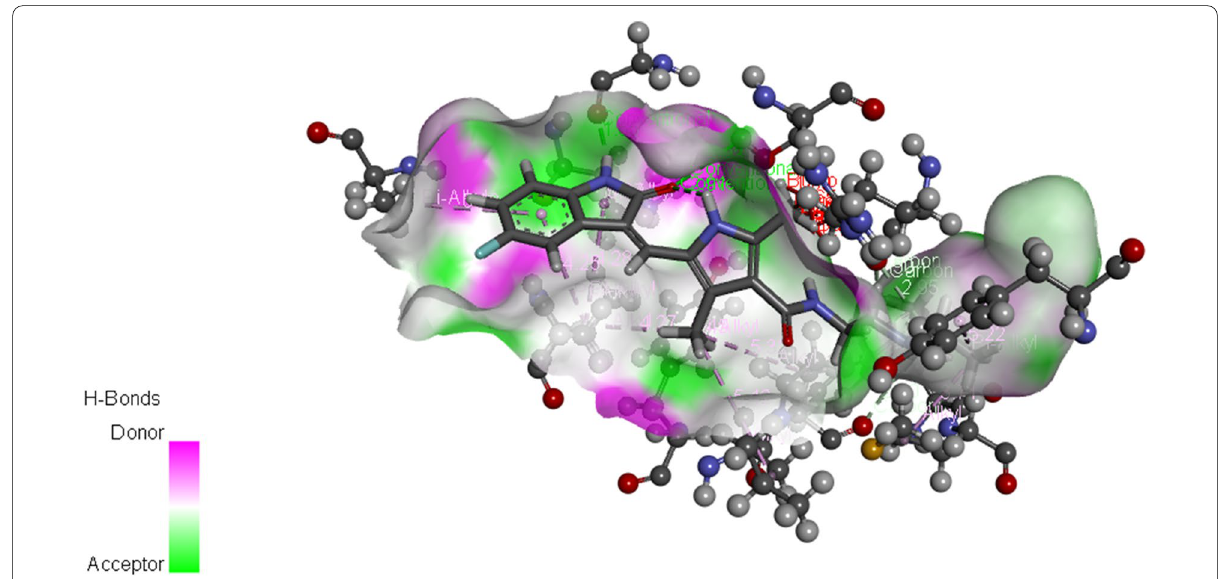
Fig. 13 3D structure of the designed Sunitinib interactions with VEGFR-2 receptor